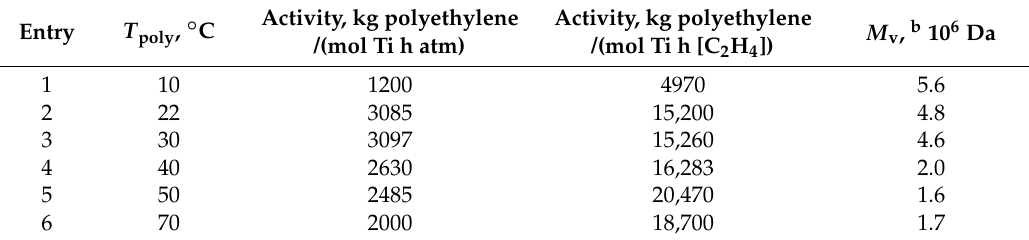
Table 1. Ethylene polymerization by {TiCl 4 /2,2 (cid:48) -dimethoxy-1,1 (cid:48) -binaphthalene/Et 3 Al 2 Cl 3 /Bu 2 Mg} catalytic systems a